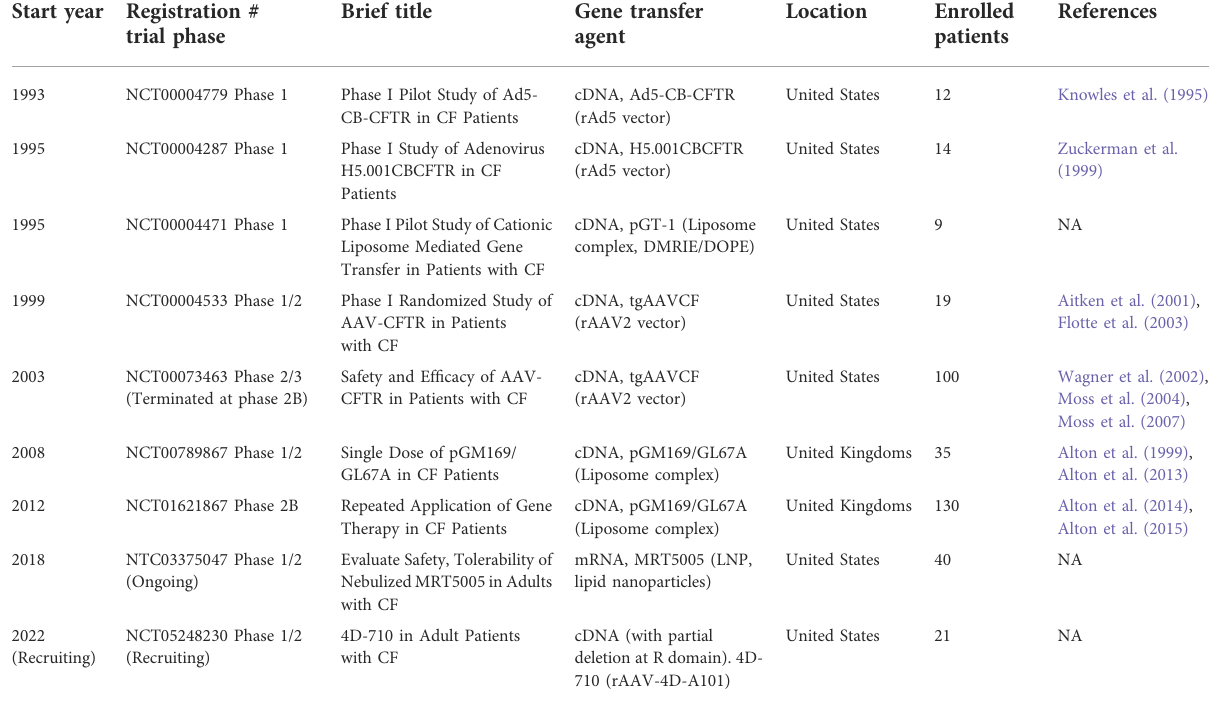
TABLE 1 Selected clinical trials of gene therapy for cystic fi brosis lung